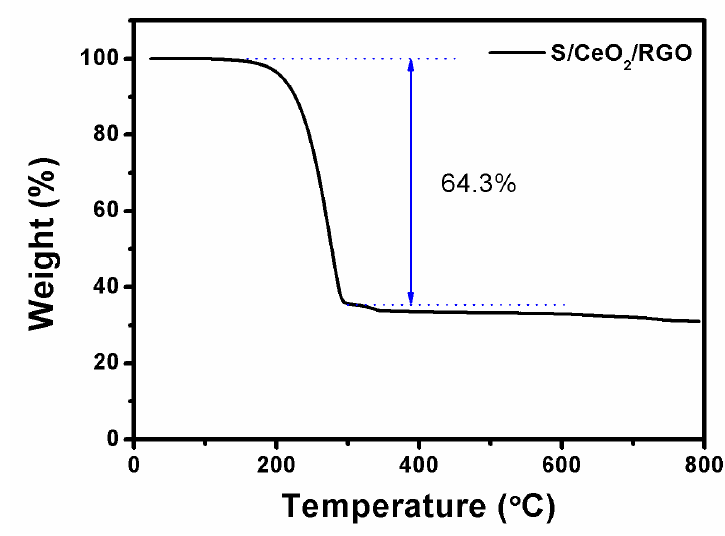
Figure 7. TGA curve of S/CeO 2 /RGO at a heating rate of 10 °C /min.